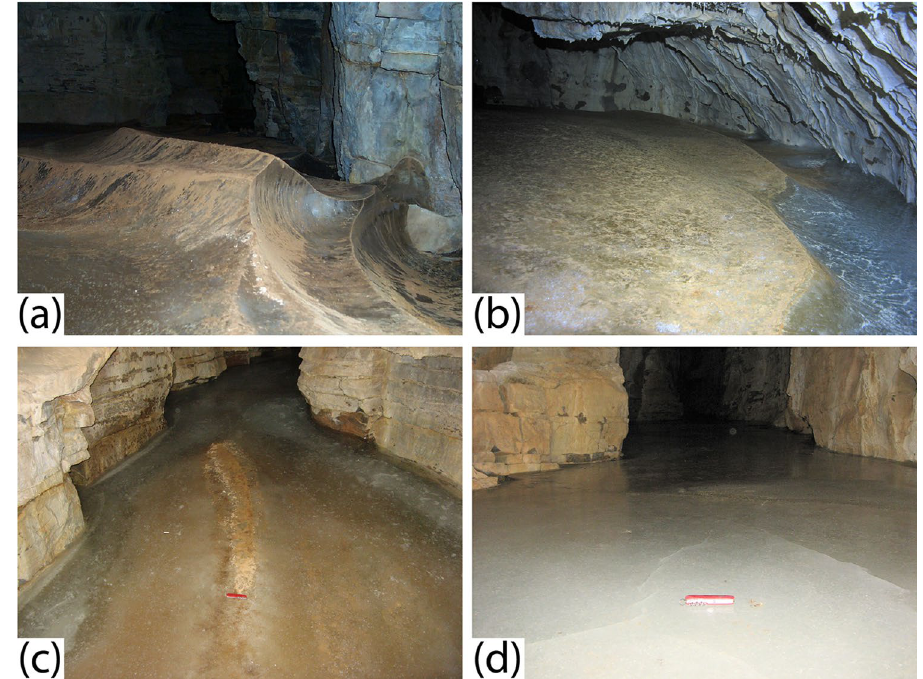
Figure 4. A selection of photographs highlighting recent changes observed in WWC. ( a ) The sculpted surface of the ice in 2016 illustrating intersecting cuspate forms produced by sublimating air currents. The total relief is ~ 30 cm. CCC is visible as tan material on the ice surface. ( b ) A view showing the edge of the ice in 2016 where a ~ 20-cm-deep moat had formed at the contact with the rock wall of the cave. ( c ) The surface of the ice in 2018 illustrating how inflowing water had submerged nearly all of the former sculpted surface beneath new ice. The red knife is located at the end of a ~ 1-m long section of a former crest in the ice that reaches barely above the new ice surface. ( d ) Another view from 2018 where new ice formed from inflowing water has completely inundated the former sculpted ice surface. Red knife is 10 cm